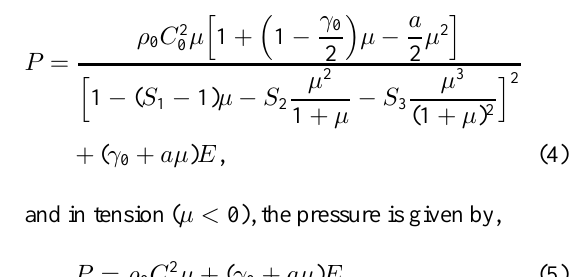
Fig. 1. Non-dimensionalized shock wave velocity vs fluid particle